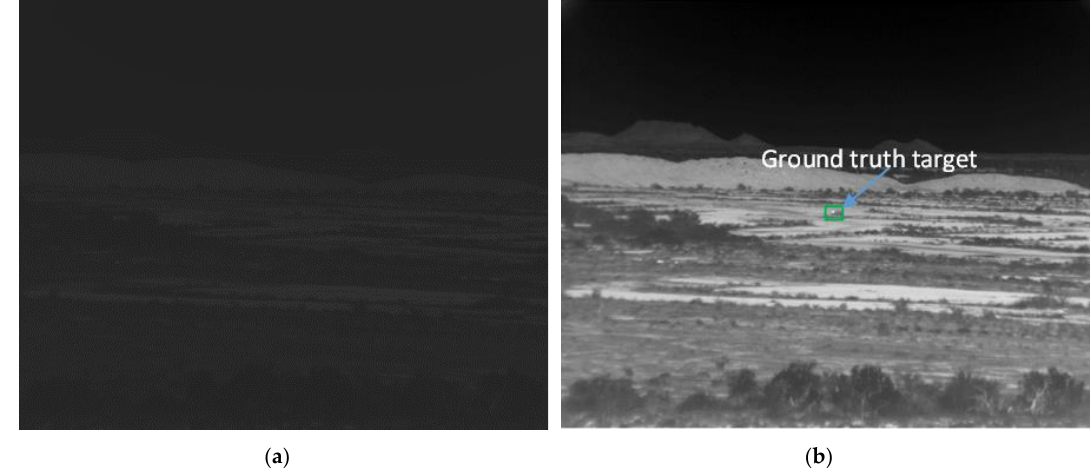
Figure A5. Before and after comparison of Approach 3a. ( a ) Raw image; ( b ) Contrast-enhanced image.